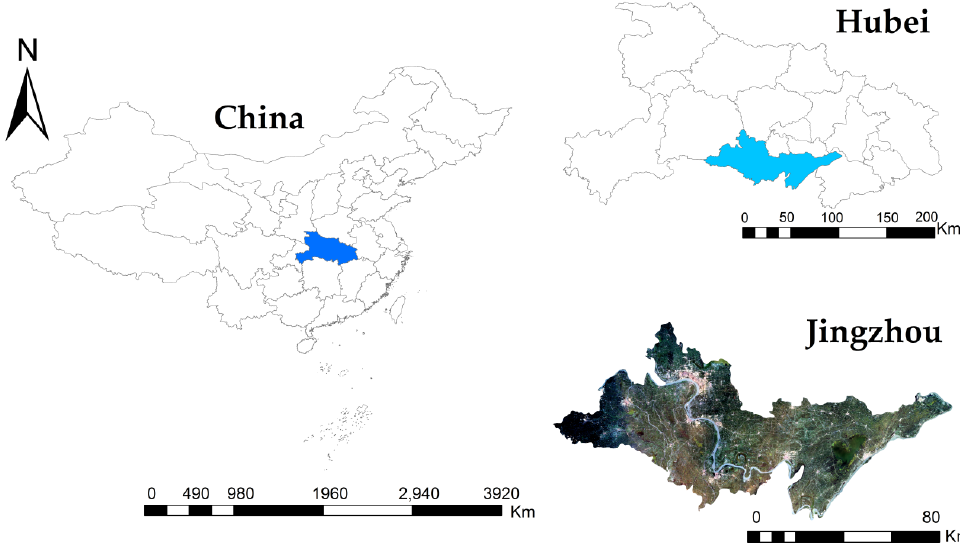
Figure 1. Location of the study site (29°26 ′ –31°37 ′ N, 111°15 ′ –114°05 ′ E).